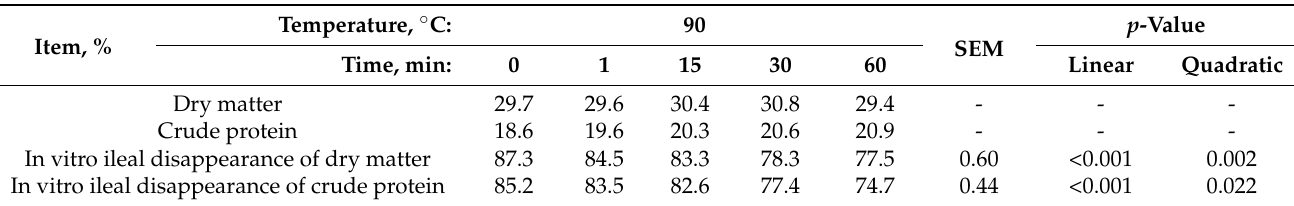
Table 2. Dry matter and crude protein concentrations in chicken meat thermally processed at 90 ◦ C (as-is basis) using water bath and the effects of heating time on in vitro ileal disappearance of dry matter and crude protein of chicken meat thermally processed at 90 ◦ C (Exp. 2) 1 .